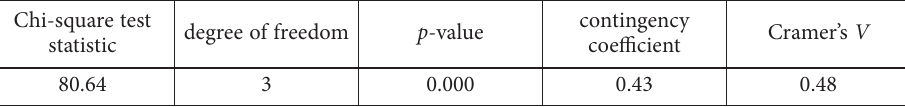
Table 8. Results of Pearson chi-square test Chi-square test degree of statistic